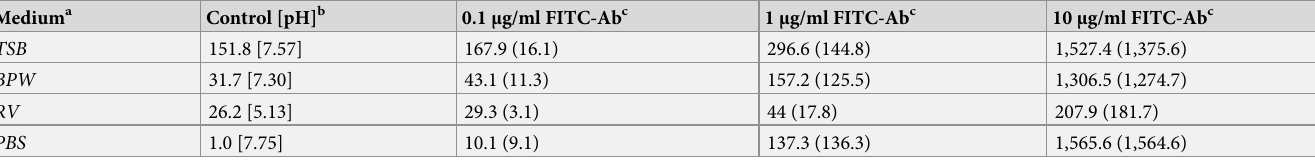
Table 2. Fluorescence and pH of medium commonly used for traditional culture of S . Typhimurium.